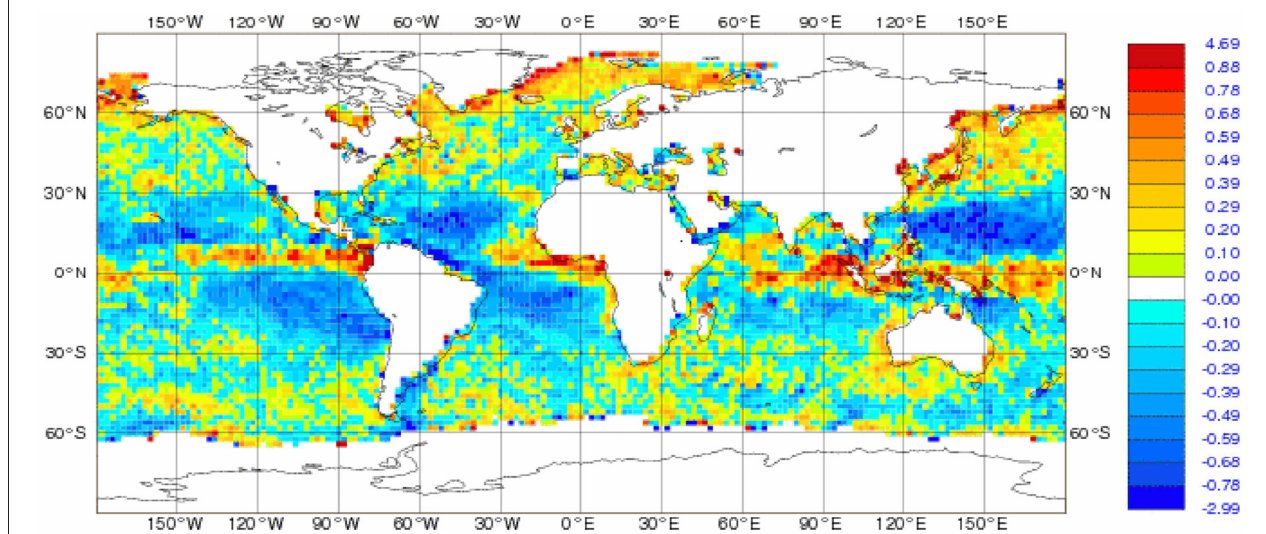
FIGURE 4 | Accumulated statistics for 10-m equivalent-neutral mean wind speed differences in ms − 1 between ASCAT-A and the European Centre for Medium-Range Weather Forecasting (ECMWF) first guess (ASCAT-A minus ECMWF) for the period from 21:00 UTC on 31 October 2015 until 9 UTC on 5 December 2015 in boxes of two by two degrees. © EUMETSAT NWP